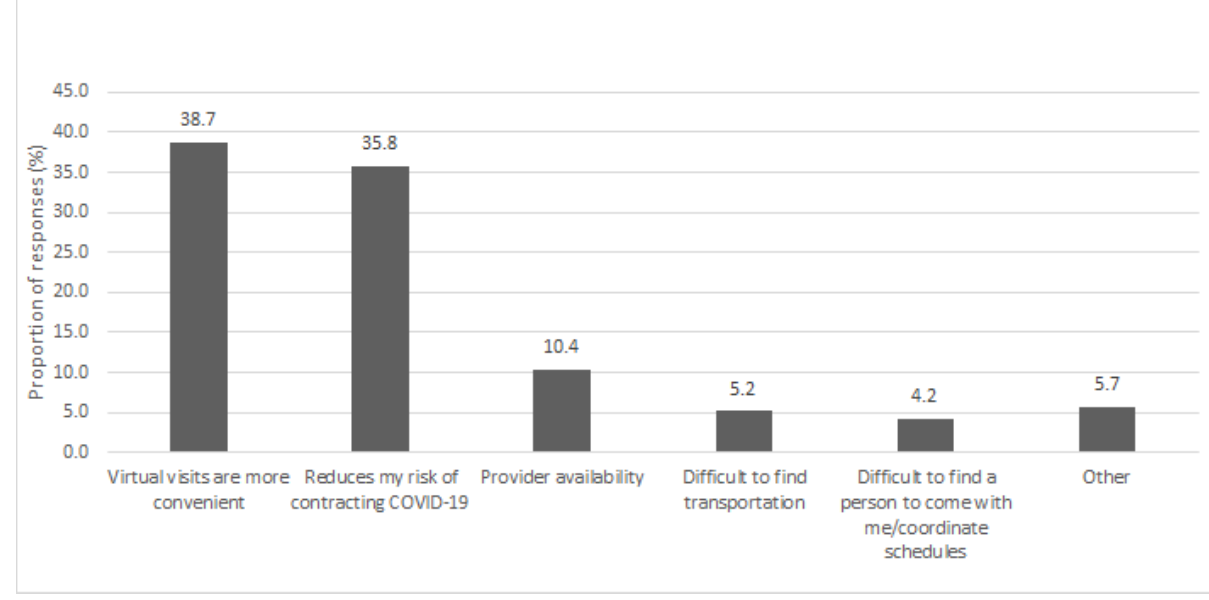
Comfort With Returning to In-Person Visits During the COVID-19